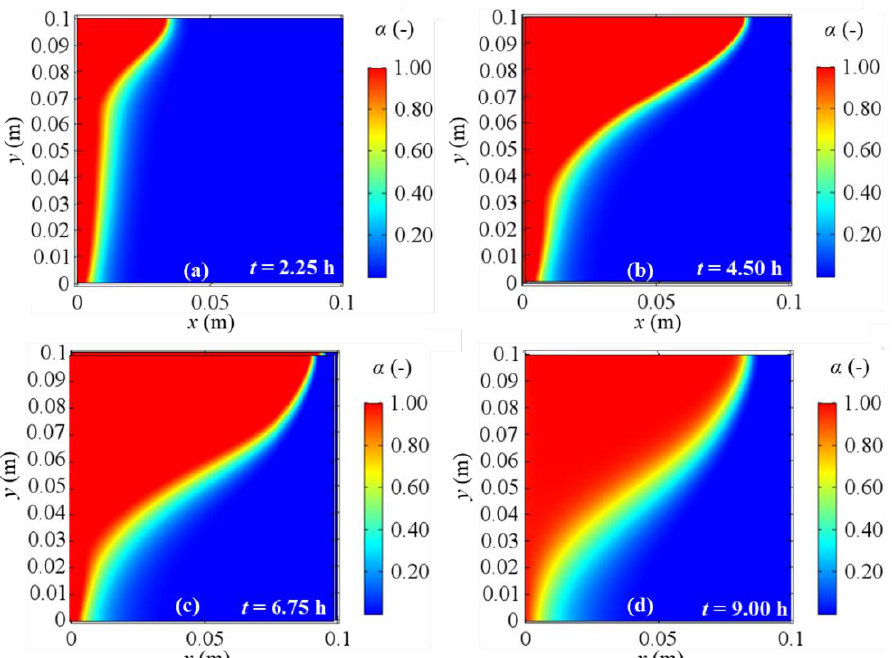
Figure 14. Melting fraction evolution for 2D model with natural convection and BC 1 at different evaluation times: ( a ) after 2.25 h; ( b ) after 4.50 h; ( c ) after 6.75 h; ( d ) after 9.00 h from the simulation beginning respectively.